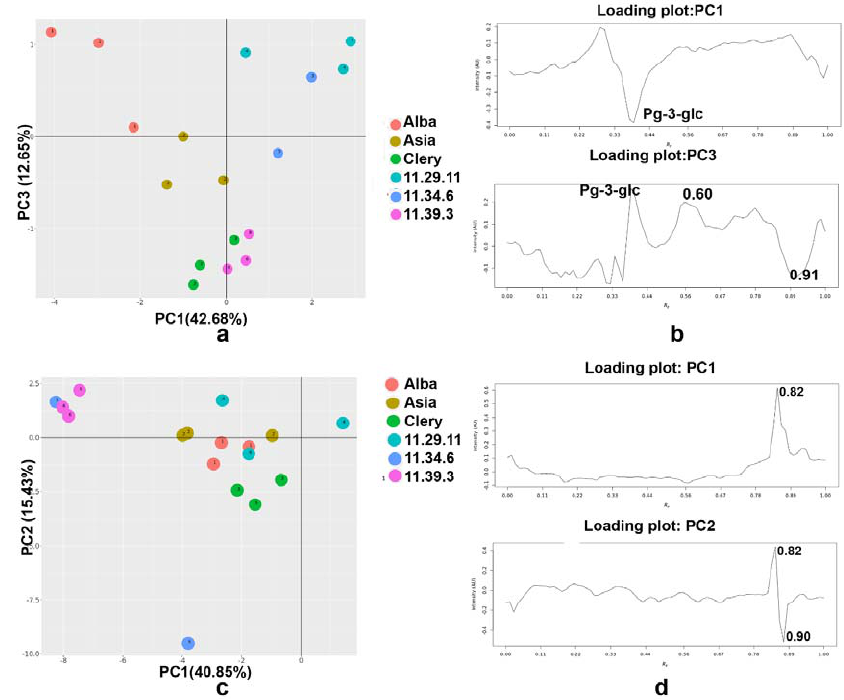
Figure 6. PCA based on effect ‐ direct analysis via Aliivibrio fischeri bioassay with ( a ) PCs score and ( b ) loading plot as well as via HPTLC ‐ DPPH . assay with ( c ) PCs score and ( d ) loading plot.